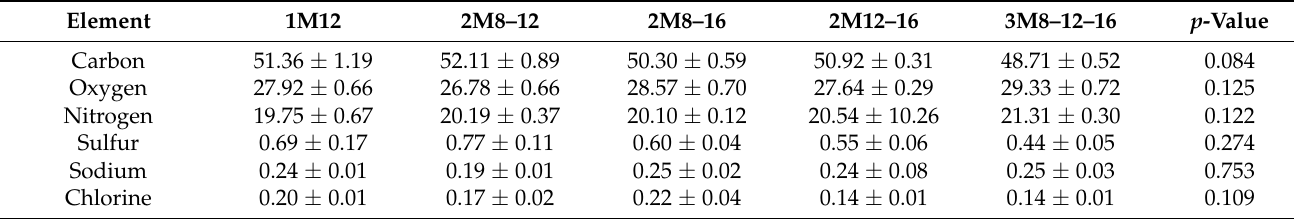
Table 4. Elemental composition (% of dry weight) in carapace of hawksbill sea turtle subjected to feeding at various frequencies. The sampling was done at the end of the 8-week